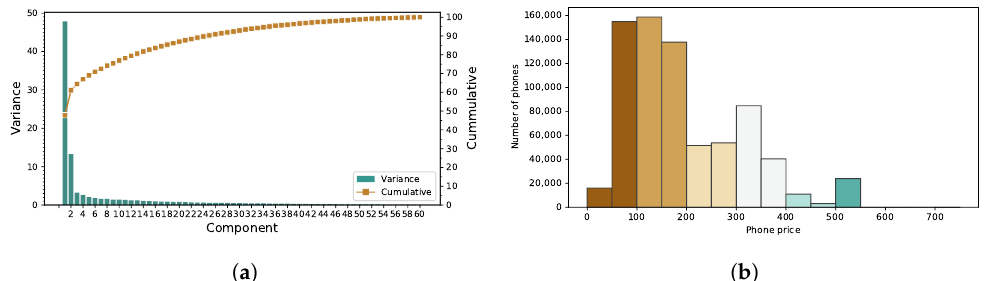
Figure 6. The Pareto histogram for the 60 components of the Principal Component Analysis (PCA) ( a ), and the phone price distribution ( b ).